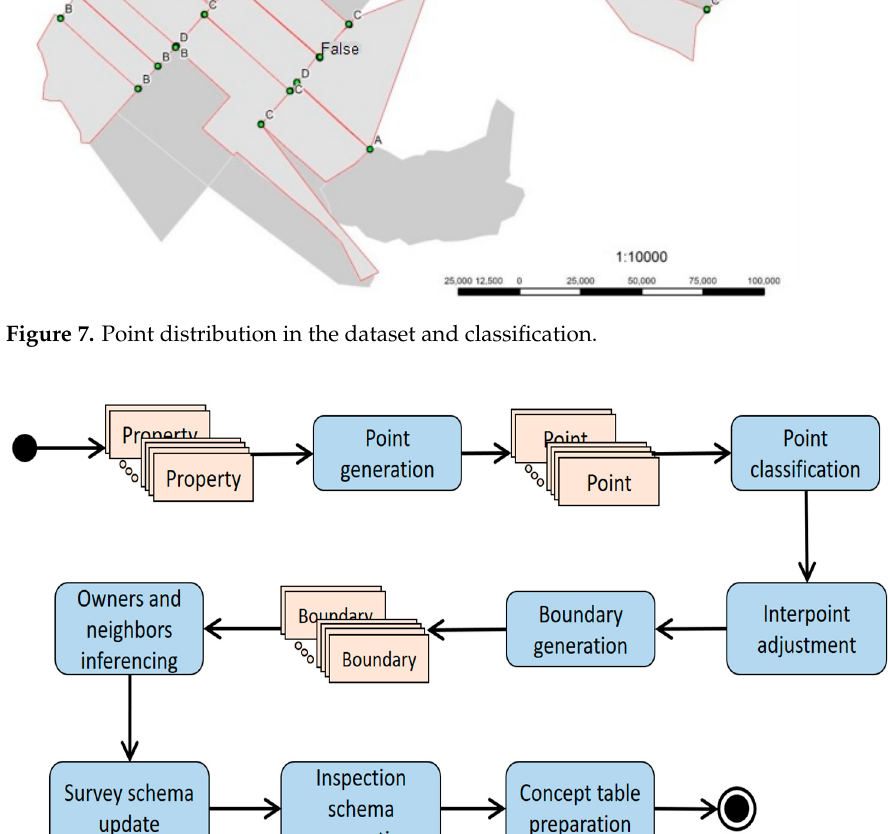
Figure 7. Point distribution in the dataset and classification.